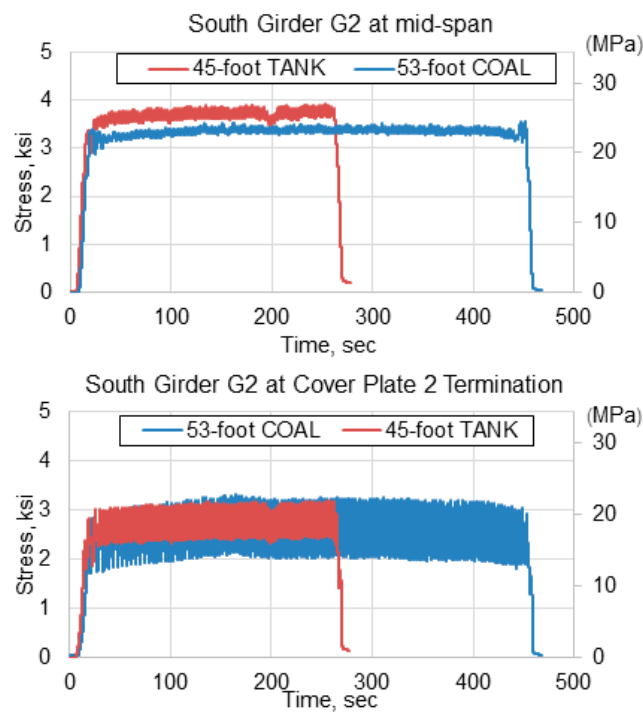
Figure 20. Stress histories obtained from measured strains in south girder G2.